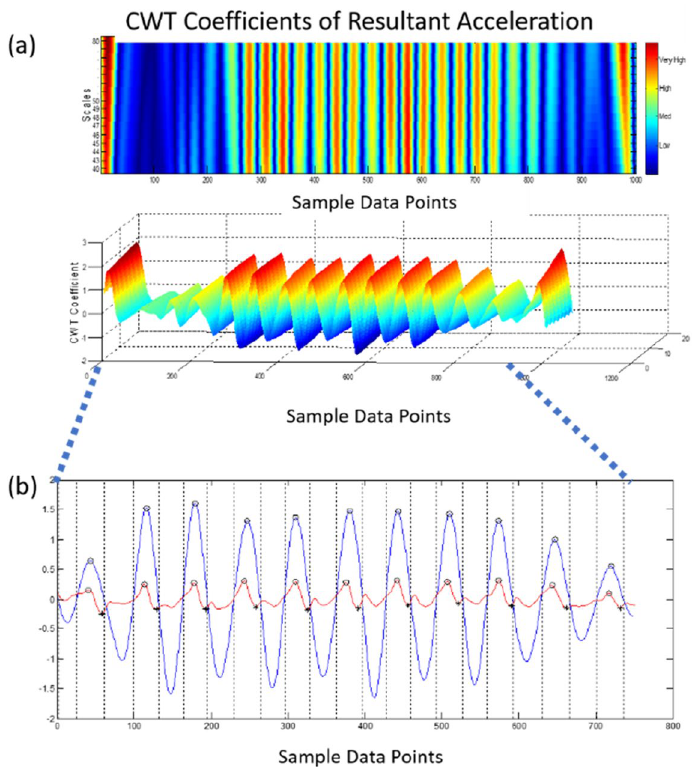
Figure 6. Detection of HC events using the CWT differentiation method. Peaks (blue) equate to HC events; the local minima in the AP acceleration (red) equate to TO